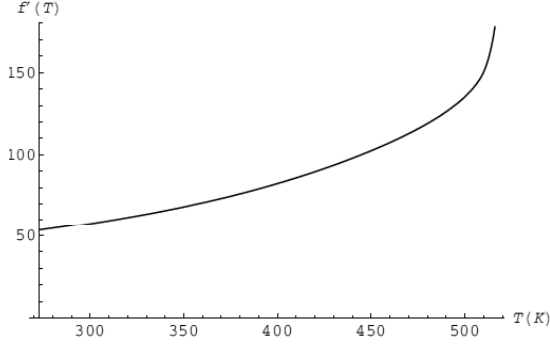
Fig. 6. f ’( T ), Eq. (28), calculated from the constant volume specific heat from Schroeder et al.